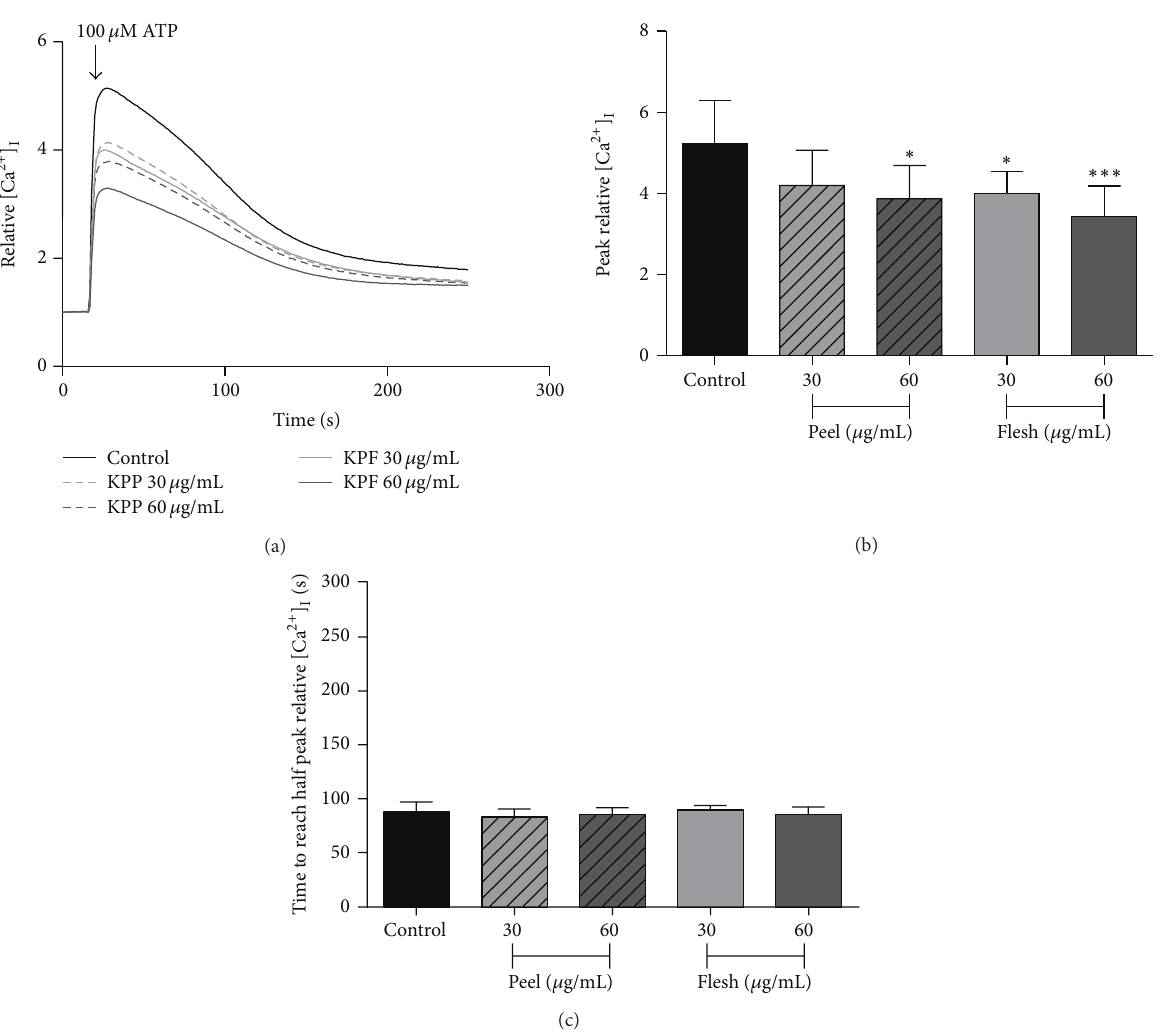
Figure 5: (a) Average relative [ Ca 2+ ] transients, (b) peak relative [ Ca 2+ ] response, and (c) time to reach half peak relative [ Ca 2+ ] I I cells treated with KP peel (P) and flesh (F) extracts for 96 h and stimulated with ATP (100 𝜇 M). Cells were loaded with Fluo-4 AM dye; relative [ Ca 2+ ] was measured using FLIPR TETRA and represented as response over baseline. Trace, mean ( 𝑛 = 9 ). Columns, means ( 𝑛 = 9 ) ± S.D. I ∗ 𝑃 ≤ 0.05 . ∗∗ 𝑃 ≤ 0.01 . ∗∗∗ 𝑃 ≤ 0.001